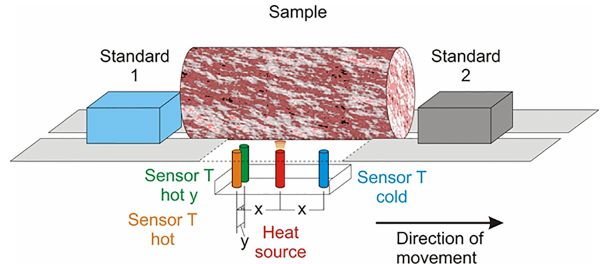
Figure 5. Scheme for thermal conductivity measurements of the analyzed core samples according to Popov et al. (1999), retrieved from Sass and Götz